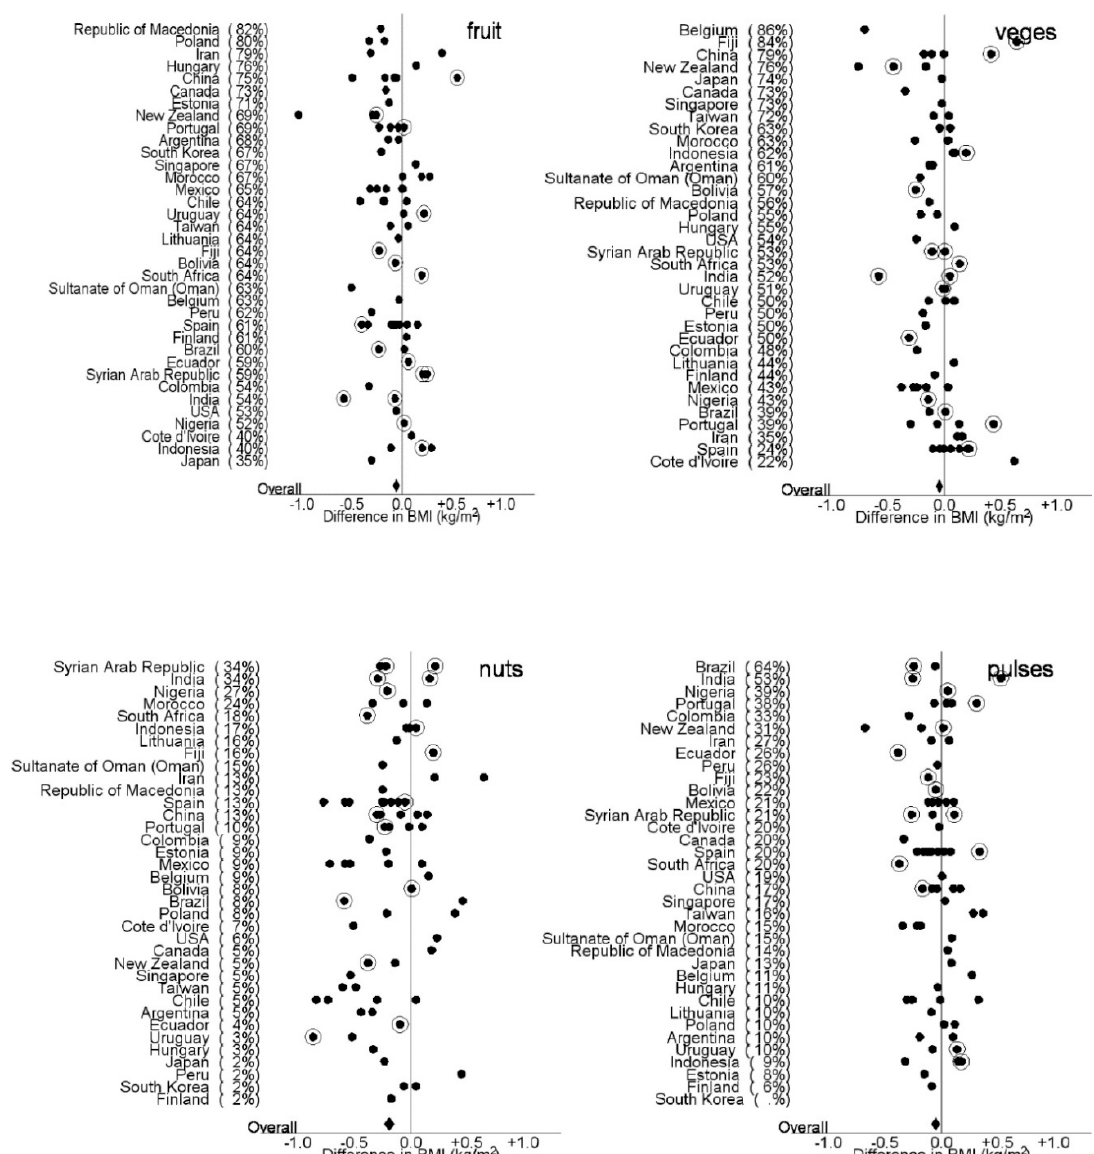
Figure 3. Differences in BMI (kg/m 2 ) between adolescents who reported eating fruit, vegetables, pulses, and nuts three or more times a week and those children who reported eating fruit, vegetables, pulses and nuts 1–2 times per week or never, in each centre after controlling for country GNI, centre, age, sex, measurement type (reported or measured). The solid diamond represents the overall effect. The proportion of participants who reported eating fruit, vegetable, pulses and nuts three or more times per week is shown in parentheses after each country. The solid dots represent centres with reported heights and weights and the circled dots represent centres that measured heights and weights.